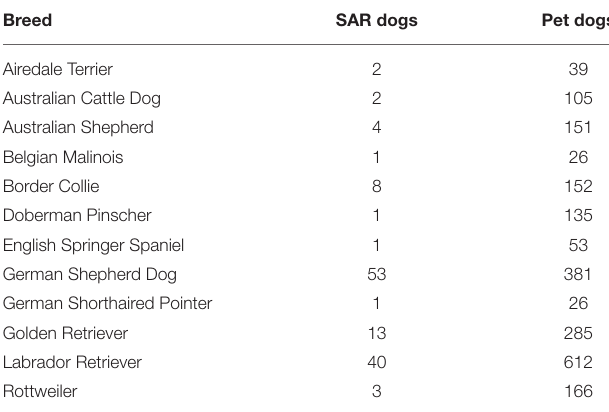
TABLE 1 | Breed distribution of dogs in 9/11 surveillance study and pet